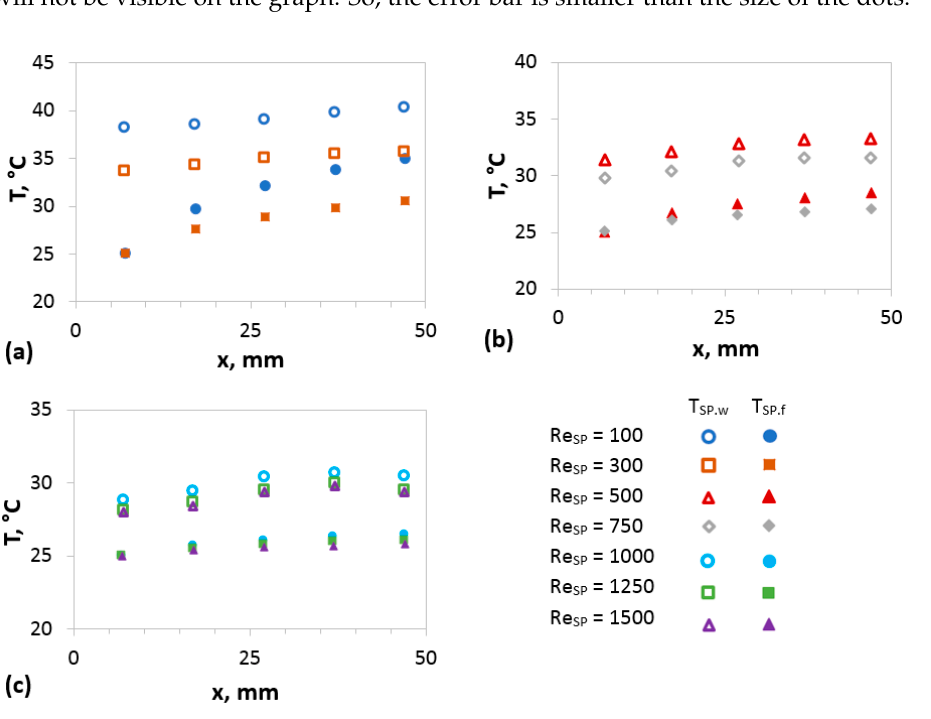
Figure 3. Dependence of the wall temperature and fluid flow along the length of the MFHE channel for a single-phase flow at ( a ) Re SP = 100, 300, ( b ) Re SP = 500, 750, ( c ) Re SP = 1000, 1250, 1500. Obviously, with an increase in the Reynolds number, the temperature of the wall and the fluid decreases. So, for Re SP = 1500 compared to Re SP = 100, the average wall temperature decreases from 𝑇 (cid:3020)(cid:3017).(cid:3050).(cid:3028)(cid:3049)(cid:3034)((cid:3019)(cid:3032)(cid:3020)(cid:3017) (cid:2880) (cid:2869)(cid:2868)(cid:2868)) = 39.2 °C to 𝑇 (cid:3020)(cid:3017).(cid:3050).(cid:3028)(cid:3049)(cid:3034)((cid:3019)(cid:3032)(cid:3020)(cid:3017) (cid:2880) (cid:2869)(cid:2873)(cid:2868)(cid:2868)) = 29.0 °C, and fluids with 𝑇 (cid:3020)(cid:3017).(cid:3033).(cid:3028)(cid:3049)(cid:3034)((cid:3019)(cid:3032)(cid:3020)(cid:3017) (cid:2880) (cid:2869)(cid:2868)(cid:2868)) = 31.2 °C to 𝑇 (cid:3020)(cid:3017).(cid:3033).(cid:3028)(cid:3049)(cid:3034)((cid:3019)(cid:3032)(cid:3020)(cid:3017) (cid:2880) (cid:2869)(cid:2873)(cid:2868)(cid:2868)) = 25.5 °C, which at 1.35 and 1.22 times lower, respectively. Additionally, it can be seen from Figure 3 that tem- peratures, as expected, increase linearly along the length of the MFHE. In this case, the lower the Reynolds number, the more significant the increase in both the wall tempera-